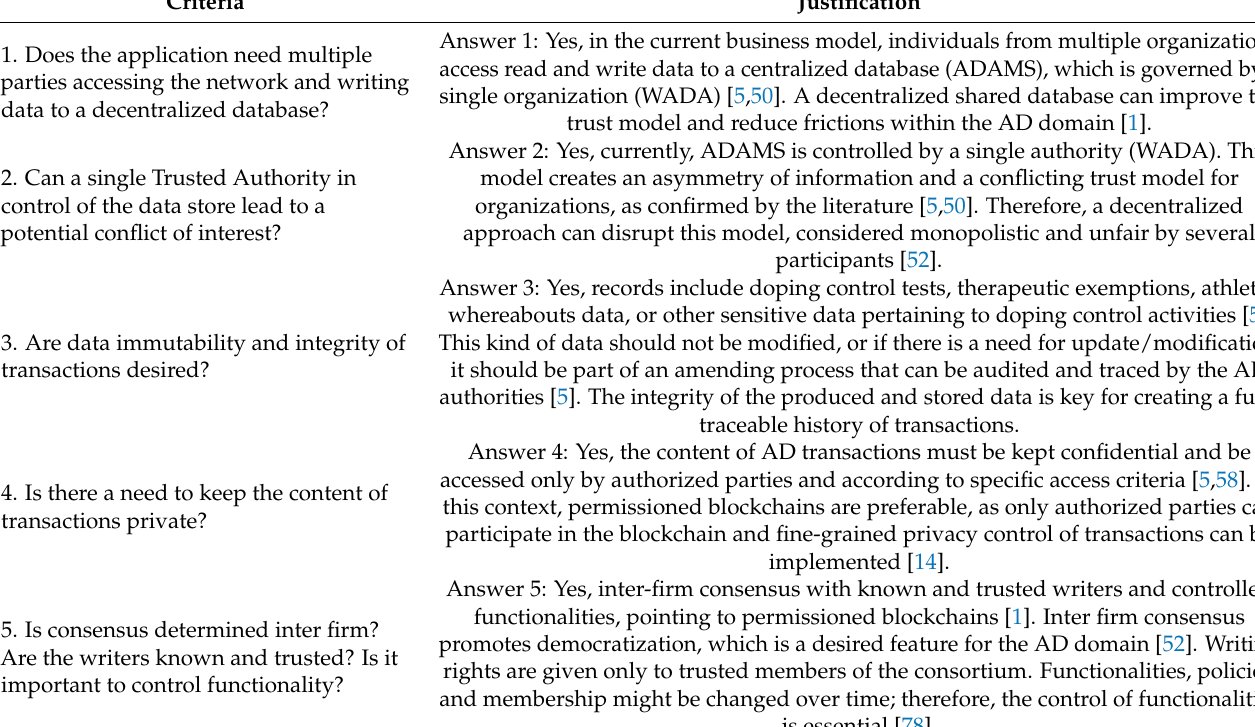
Table 1. Blockchain suitability